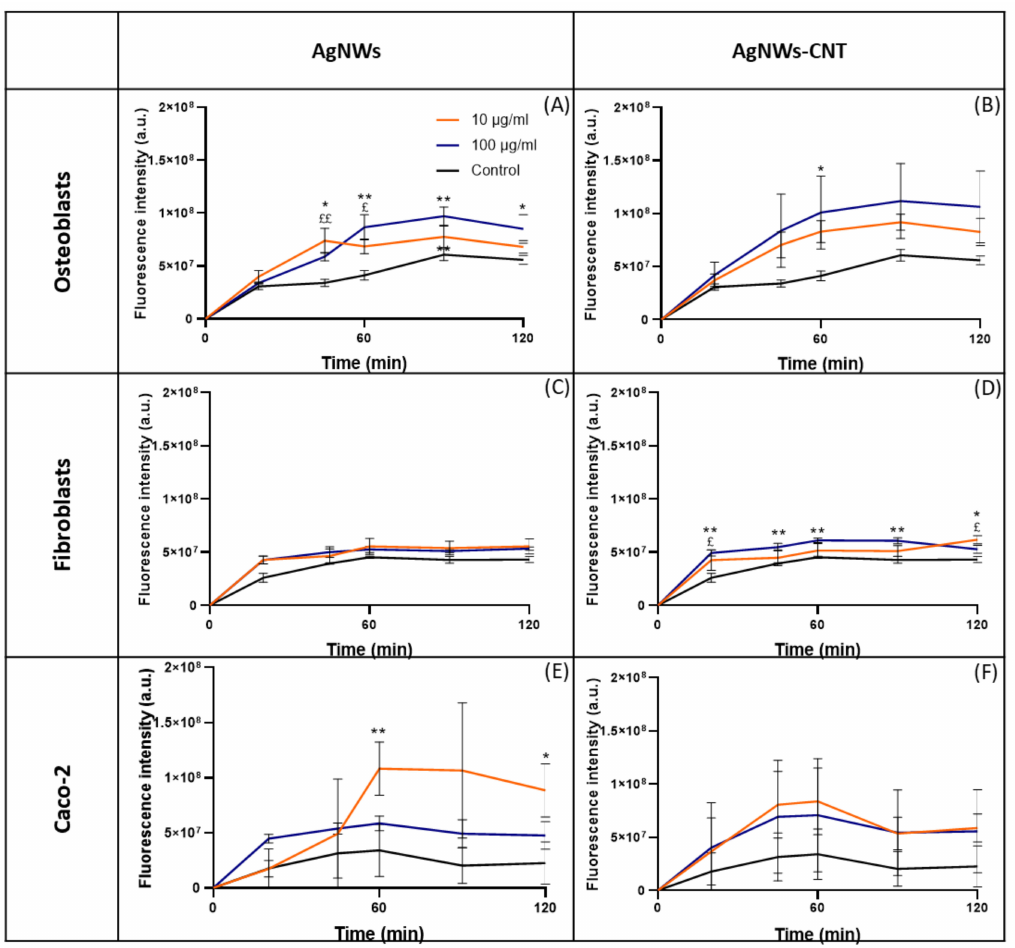
Figure 7. Time course of ROS production in di ff erent cell lines: osteoblasts ( A , B ), fibroblasts ( C , D ) and Caco-2 ( E , F ) treated with AgNWs or AgNWs-CNT for 15 min. One-way ANOVA returned p < 0.05. Data are reported as the mean ± SD ( n = 3). Results of the post-hoc Tukey multicomparison test are shown in the graph: *was used to compare 100 with 0 µ g / mL (* indicates p < 0.05 and ** indicates p < 0.01); $ was used to compare 10 with 0 µ g / mL ( $ indicates p < 0.05 and $$ indicates p <